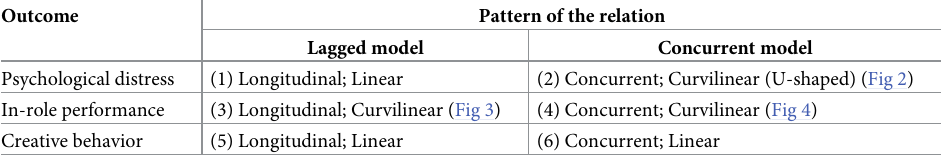
Table 5. Pattern of the relation between work engagement and